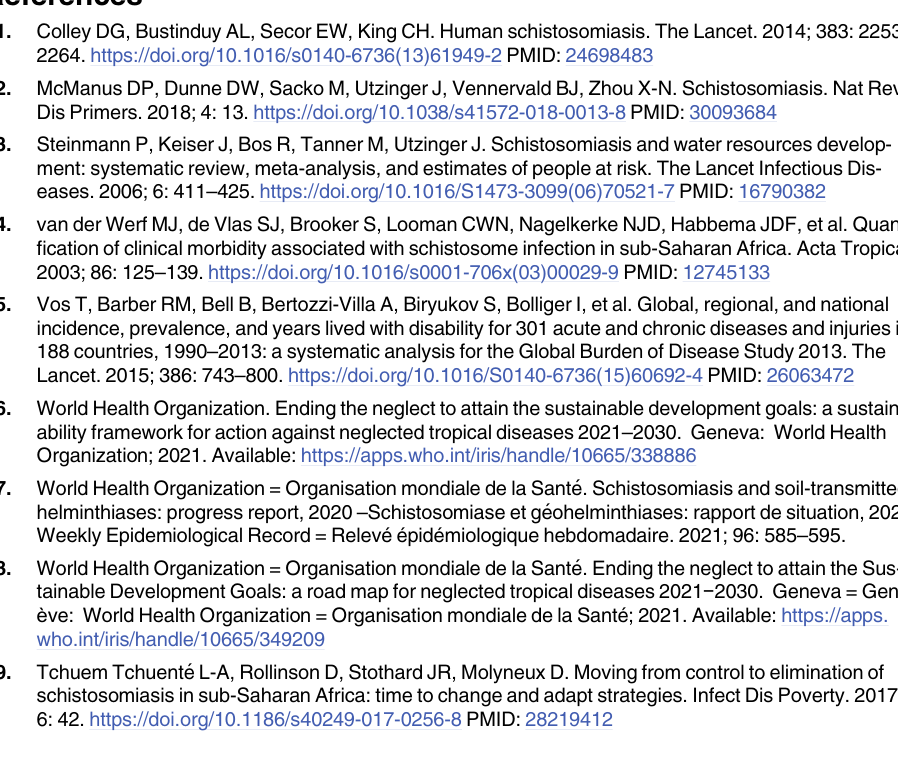
S1 Fig. ROC plot of LSV Value for specific identification of cercariae in the blind-test data-